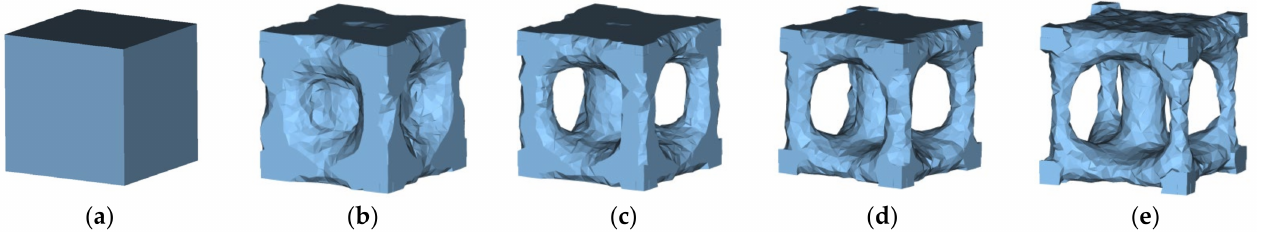
Figure 3. Intermediate shapes. Different iteration stages ( b – e ) from the initial design area ( a ) of Topology Optimized ‘structure #1’: ( a ) design area, ( b ) step 5, ( c ) step 10, ( d ) step 18 and ( e ) step